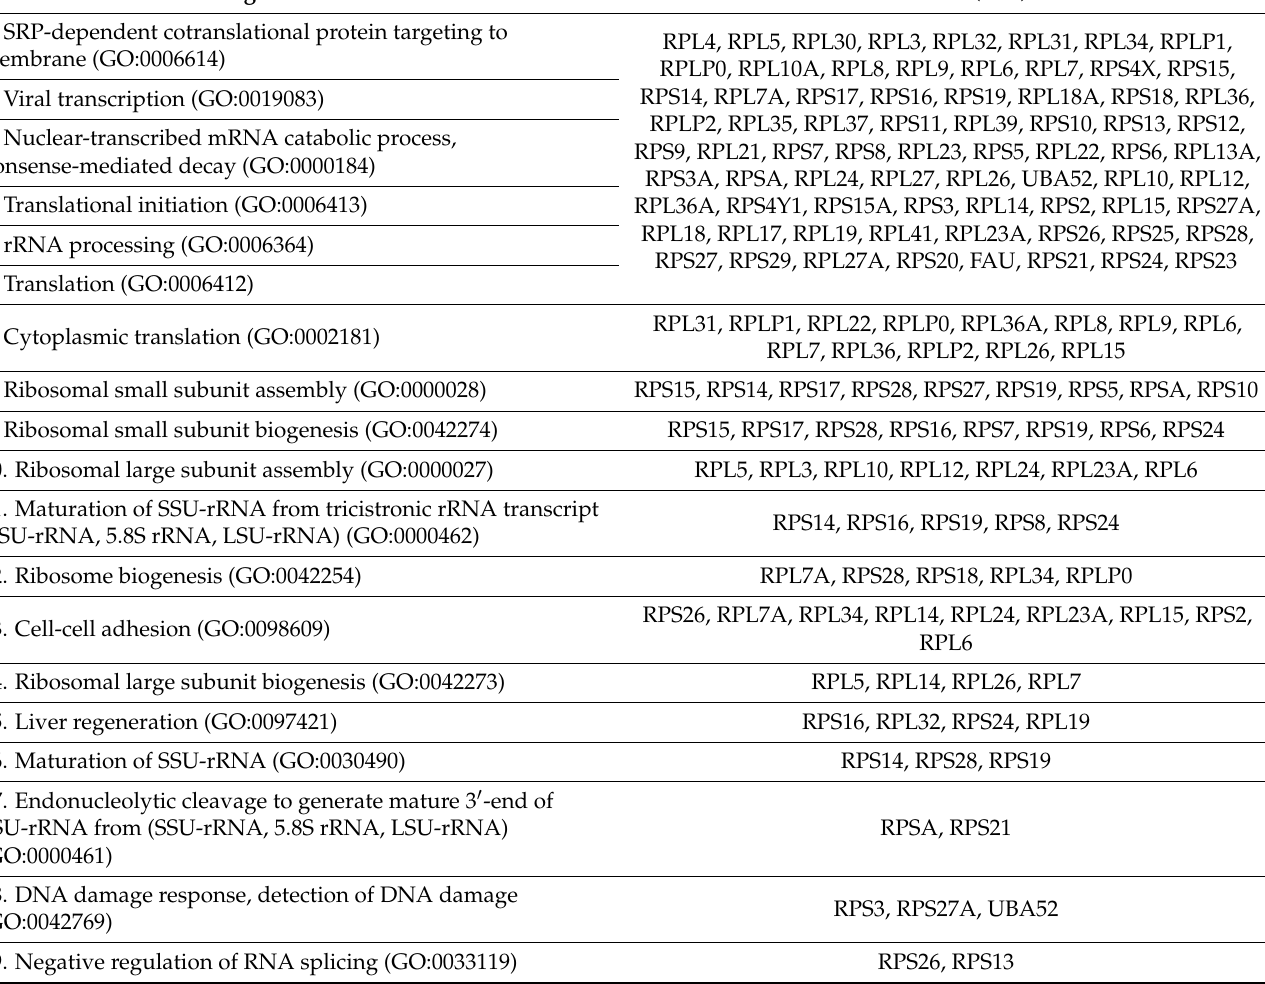
Table 1. Clustering of the human Ribosomal proteins (RPs) according to their involvement in the biological processes. Biological Processes Ribosomal Proteins (RPs)